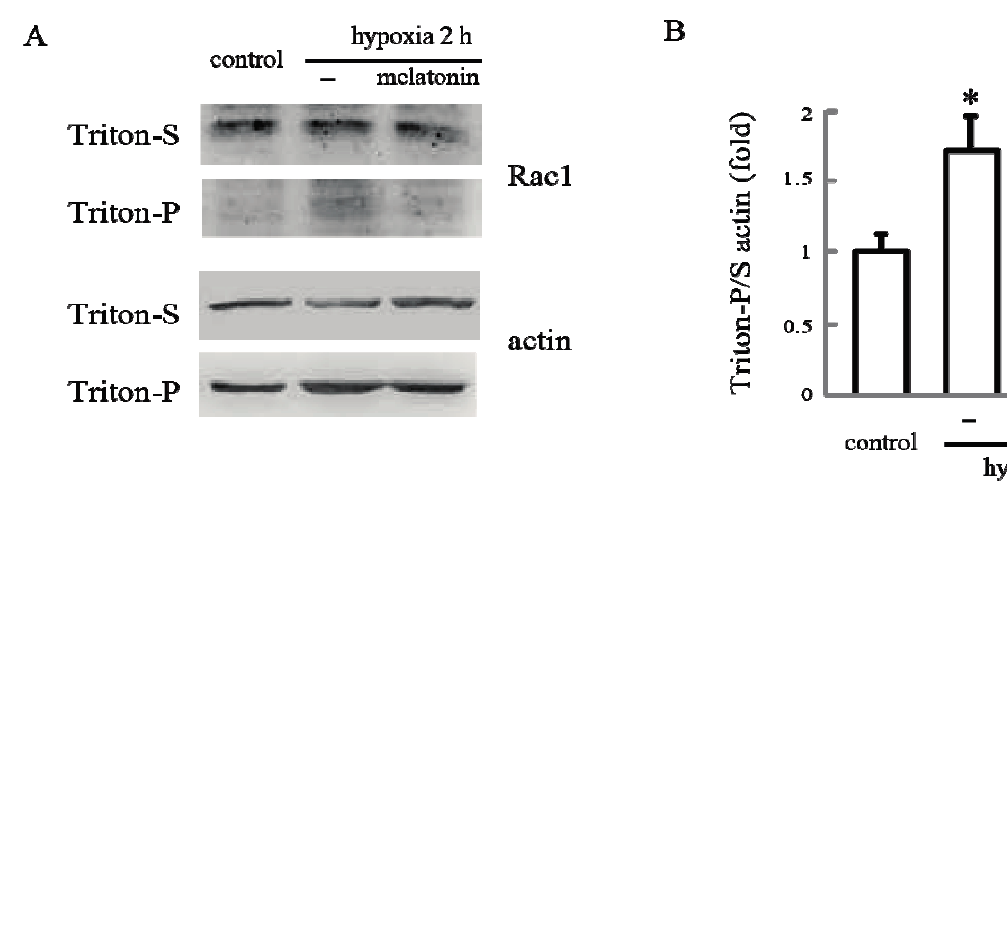
Figure 3. Melatonin inhibits hypoxia-induced Rac1 redistribution. ( A , B ) Redistribution of Rac1 and actin during hypoxia. After being treated with or without melatonin for 24 h, HUVECs were incubated under normoxia or hypoxia for 2 h. Rac1 and actin in equal amounts of Triton X-100-soluble and -insoluble fractions were detected by western blotting. Each bar graph represents the mean ± SD of three independent experiments. * p < 0.05, referring to the difference between cells treated with and without hypoxia; # p < 0.05, referring to the difference between cells treated with melatonin and hypoxia relative to the cultures exposed to hypoxia alone; and ( C ) Melatonin reverses hypoxia-stimulated Rac1 translocation in HUVECs. After pretreatment with 100 µM of melatonin for 24 h, cells were grown under hypoxia for 2 h and stained for Rac1 (red) and F-actin (green), as described in the Materials and Methods Section. Cells were counterstained with DAPI (blue). Images are representative of at least three independent determinations. The illustrations in the right side column show the merged magnified images in the white border boxes, white arrows point to the co-localization of Rac1 and F-actin on the membrane of HUVECs. Magnification, 400×. Scale bars, 10